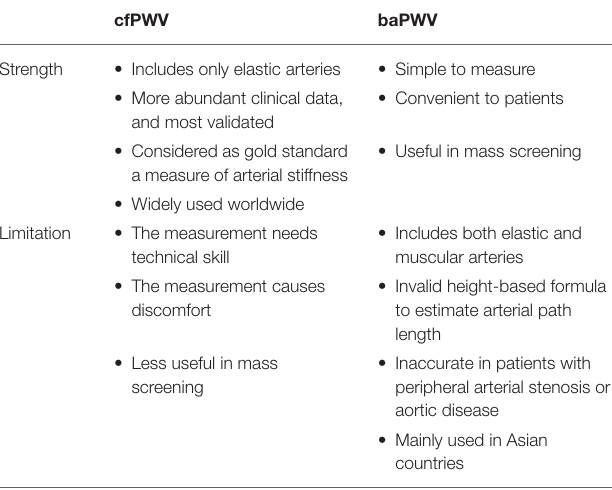
TABLE 5 | Comparisons between cfPWV and baPWV (25, 110–112). cfPWV